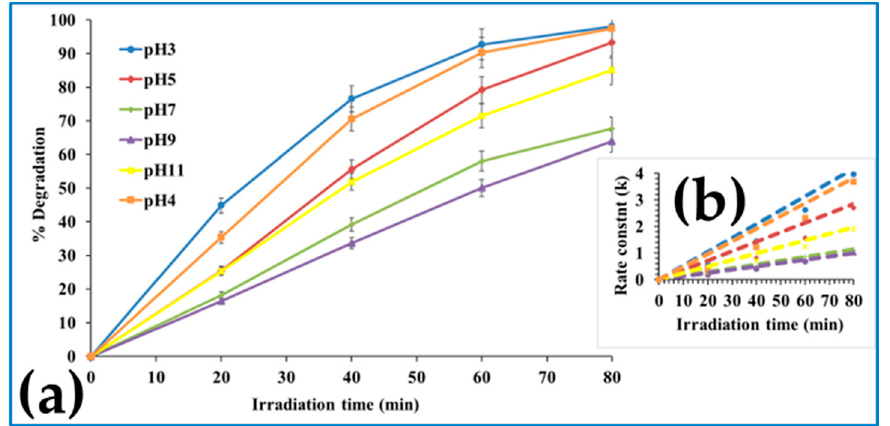
Figure 12. ( a ) Effect of pH on the photocatalytic degradation performance of 1 g/L Mo/HRTiO 2 over 50 mg/L initial IBU concentration under 365 nm irradiation, and ( b ) their corresponding photocatalytic degradation rate constant (k).